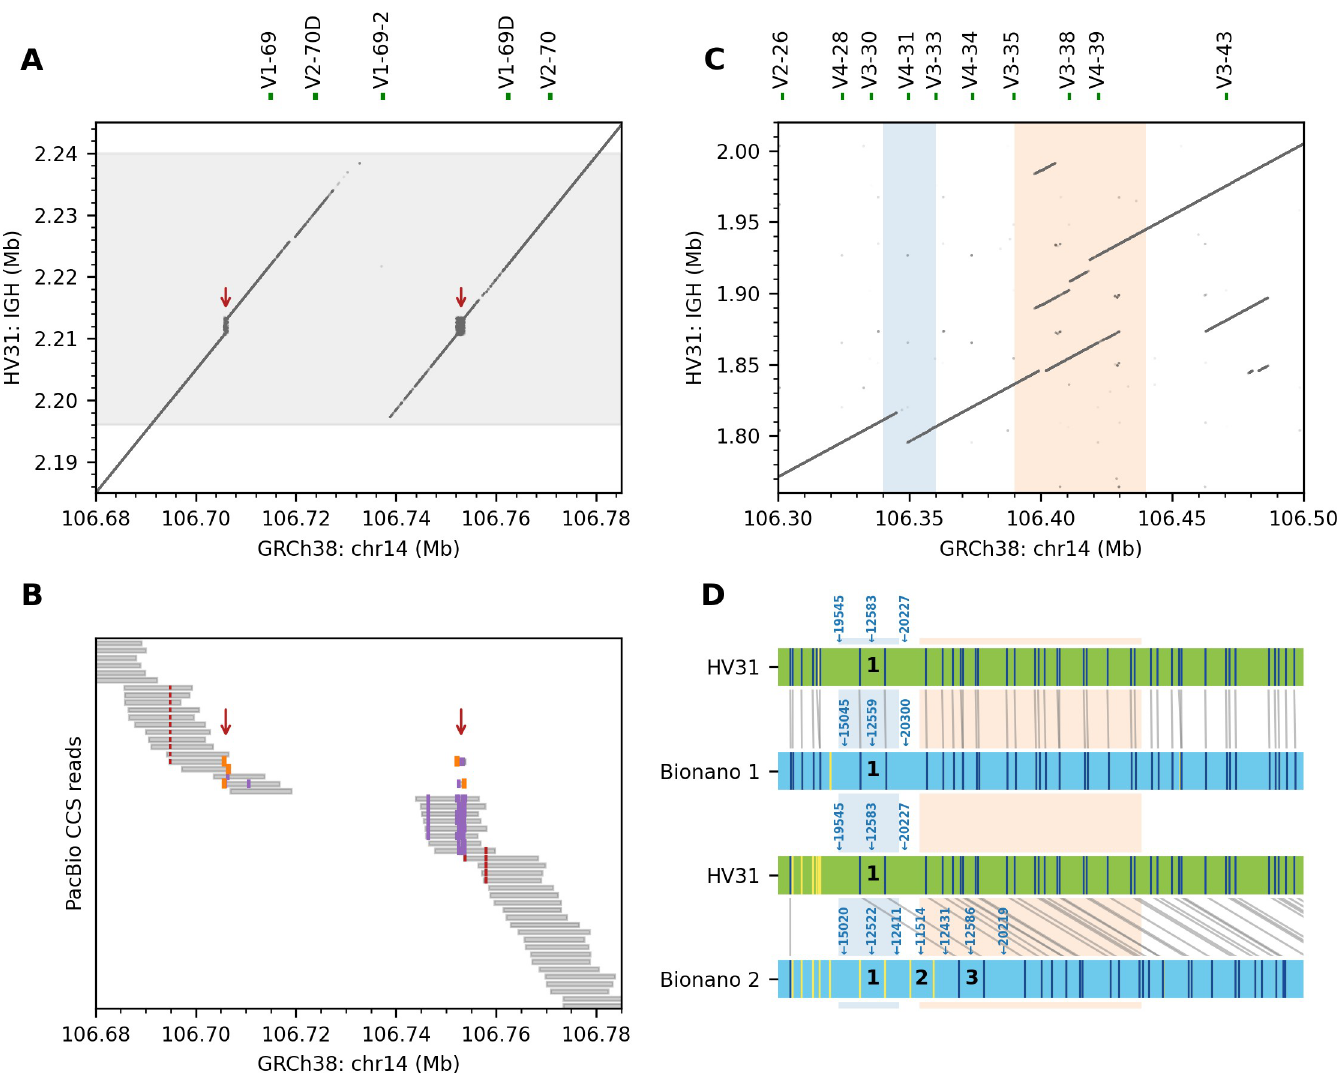
Fig 5. IGHV genes feature highly variable copy numbers. (A) Collapsed repeats (i.e. repeats incorrectly assembled in a single copy; red arrows) in GRCh38 were resolved in the HV31 assembly inside a 45 kb copy number contraction (i.e. reduction in copy number of a repeat unit relative to GRCh38, shaded in grey). (B) Pileup of HiFi reads aligned to GRCh38. The 45 kb CNV was evident from the uncovered central region. The resolved repeats were shown as alignment breakpoints (orange) or insertions (purple) within the aligned segments (gray). Nearby short deletions (red) were also evident. (C) k-mer sharing plot (k = 50) showing complex structural variations found between IGHV3-21 and IGHV3-43 , including a 25 kb copy number contraction (i.e. reduction in copy number relative to GRCh38 of a repeat unit; blue) and an 80 kb complex duplication event (orange). (D) Alignment patterns of HV31 assembly and two Bionano contigs covering the region shown in (C). The four rows show the HV31 assembly (green horizontal bars) and two Bionano contigs (blue horizontal bars). Vertical/diagonal grey lines between HV31 and the Bionano contigs show alignments of DLE-1 recognition markers; alignments are computed by the Bionano Solve algorithm based on inter-marker distances. The relevant marker positions are indicated by vertical lines inside the contigs (colored dark blue for aligned markers and yellow for markers that were not aligned). The alignment patterns indicate that Bionano contig 2 contains an expansion consistent with the triplication of the region highlighted in blue. Black numbers indicate the approximate repeat units and relevant inter-marker distances are annotated above the